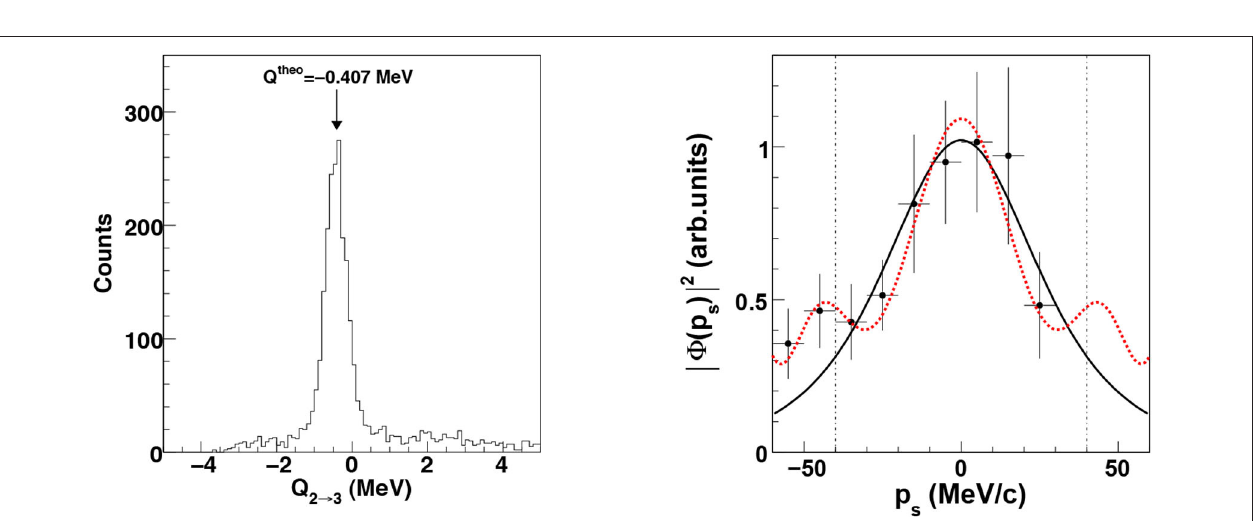
FIGURE 10 | (Left) Reconstructed Q -value spectrum. The theoretical value of − 0.407 MeV for the 2 H( 17 O, α 14 C) 1 H reaction is reported with the black arrow and it is in good agreement with the experimental peak. (Right) Experimental momentum distribution (full dots) compared with theoretical ones, given by the square of the Hulthén wave function in momentum space (black solid line) and by the DWBA momentum distribution evaluated by means of the FRESCO code (red dotter lines). The agreement is a necessary condition for the presence of the QF-mechanism in the